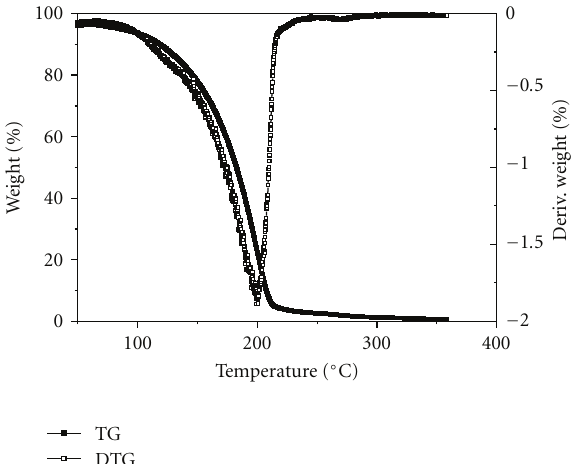
Figure 3: TG and DTG curves of fire-retardant agent 1b.